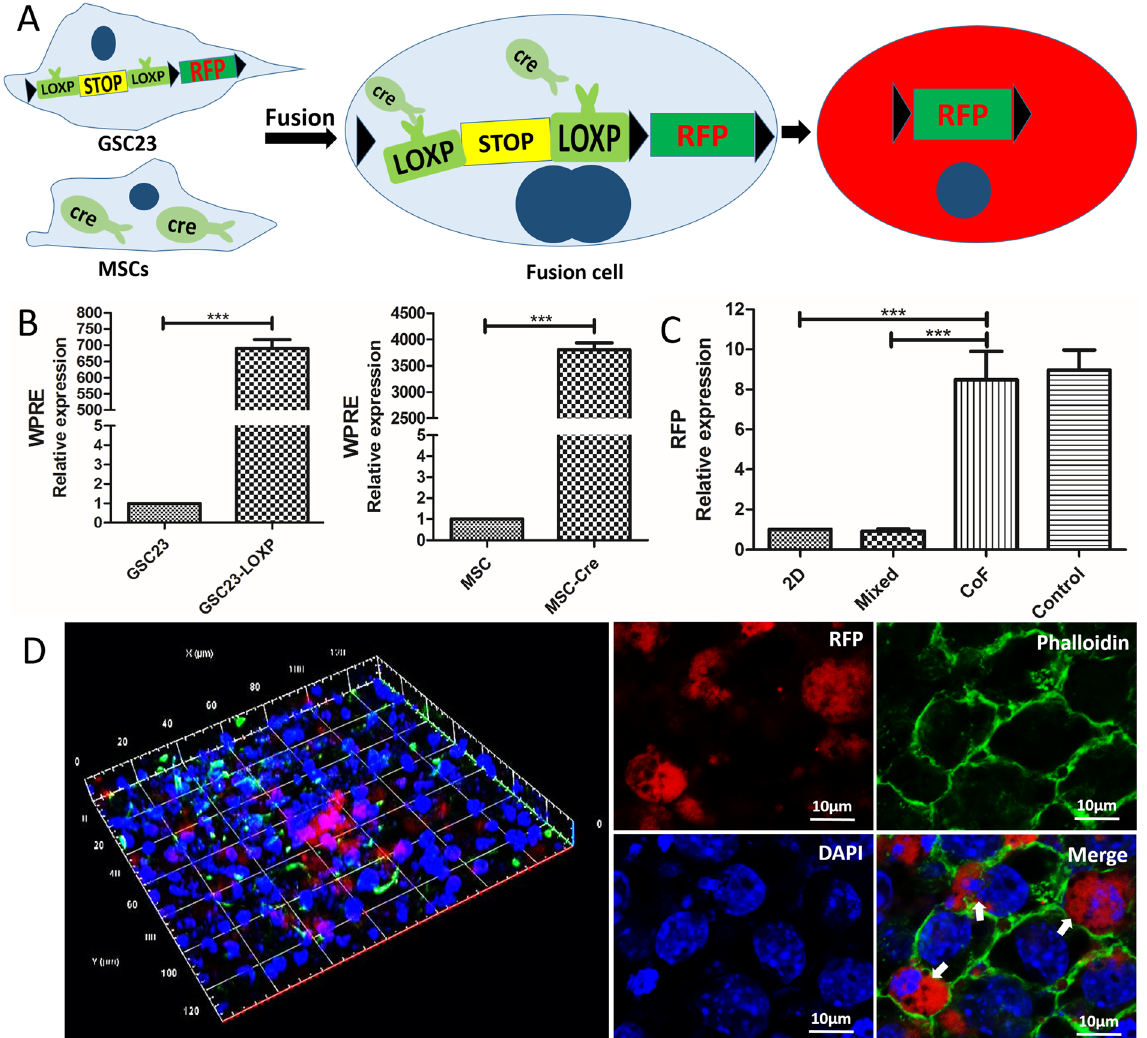
Figure 8. Cell fusion. ( A ) Schematic of interaction principle between CRE enzyme and LOXP-STOP- LOXP –RFP gene; ( B ) qRT-PCR validation of the transfection efficiency in GSC23 and MSC cells; ( C ) qRT-PCR validation of the RFP expression in CoF, comparing to 2D group, mixed group and coaxial group without adding fibrinogen to cell suspension (control); ( D ) Confocal images of GSC23-MSCs fibers, red is RFP (white arrow), phalloidin was used to stain the cytoskeletal structures (green) and DAPI was used to stain the cell nucleus (blue). Scale bars: ( D ) 10 μ